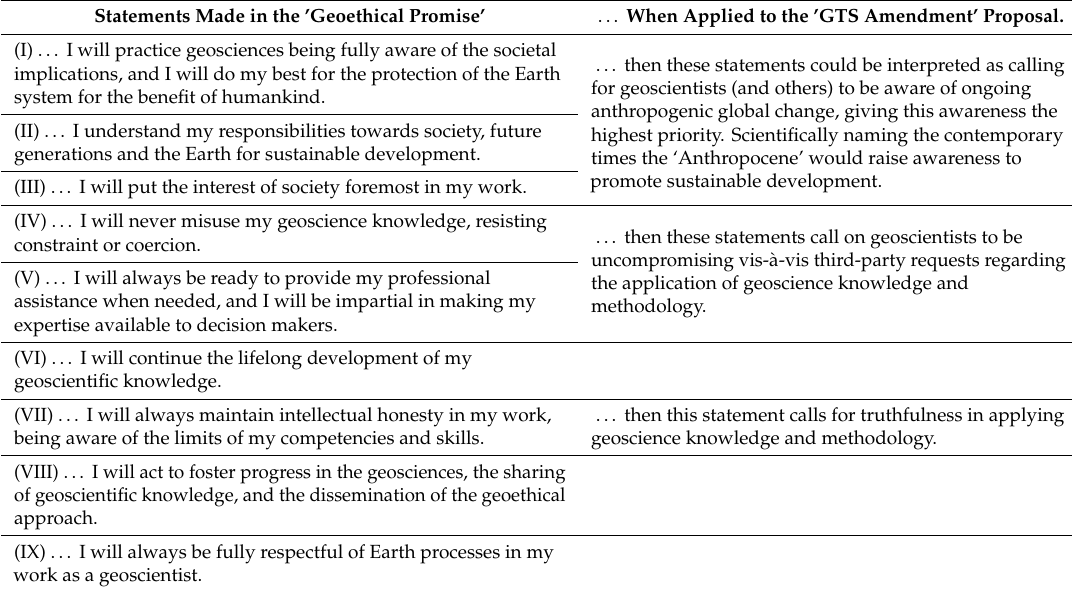
Table 1. Geoethical promise applied to the ‘GTS